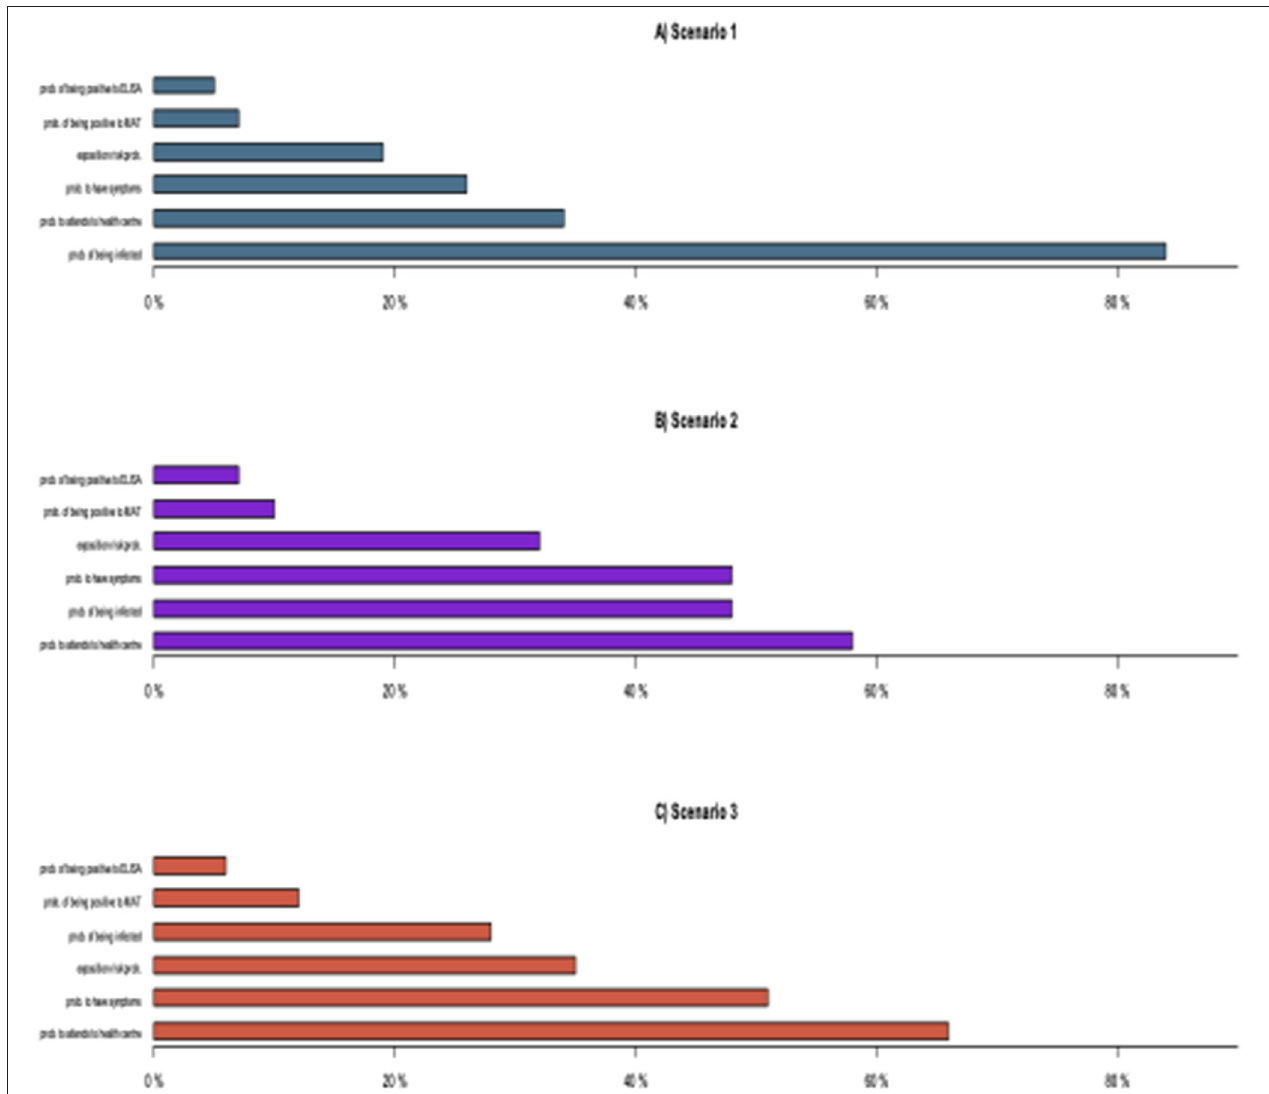
FIGURE 8 | Probabilistic sensitivity analysis. (A) For scenario 1 (Andean Region); (B) for scenario 2 (Amazonian Region); (C) for Scenario 3 (Coast